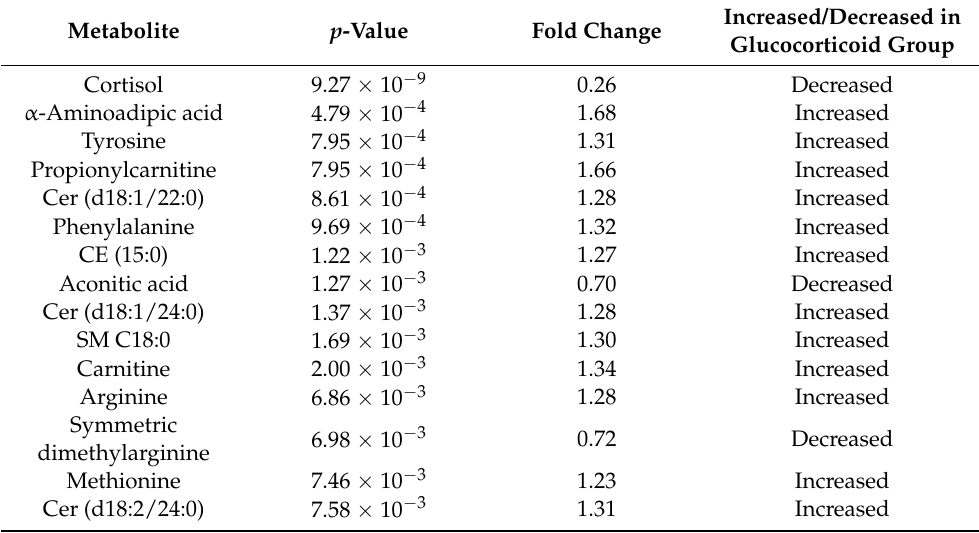
Table 2. Top 15 metabolites ranked by p-value between treated and untreated cohorts measured by